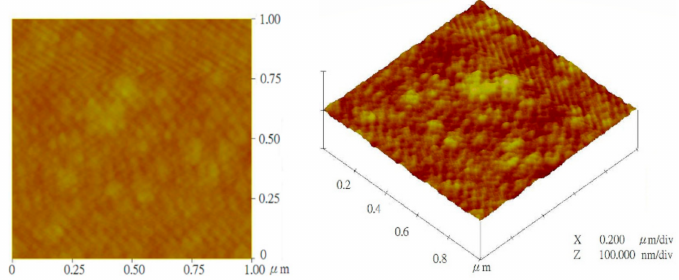
Figure 7. Surface roughness of the notch filter measured by